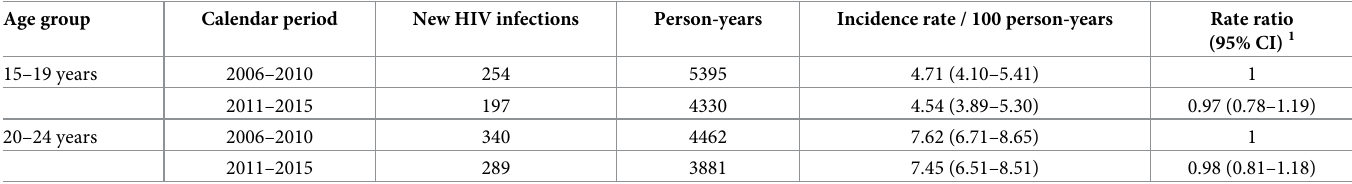
Table 2. HIV incidence estimates in AGYW aged 15–24 years, by age group and calendar period. Age group Calendar